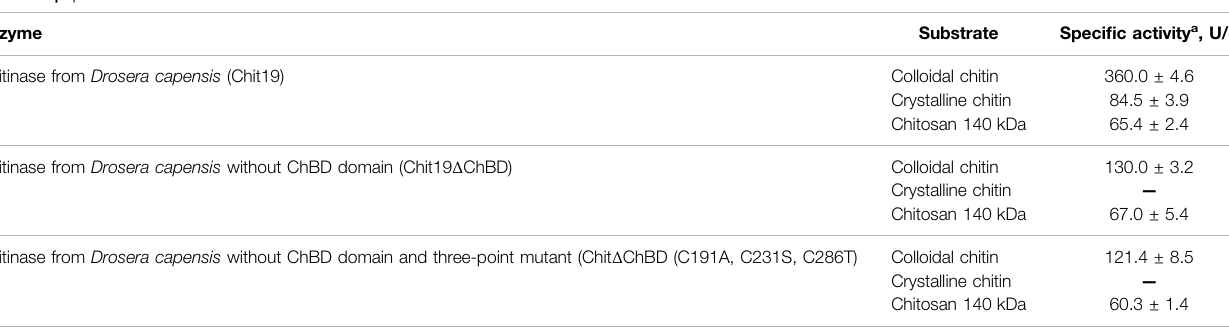
TABLE 2 | speci fi c activities of the native and mutant forms of Chit19. Enzyme Substrate Speci fi c activity a , U/g Chitinase from Drosera capensis (Chit19)